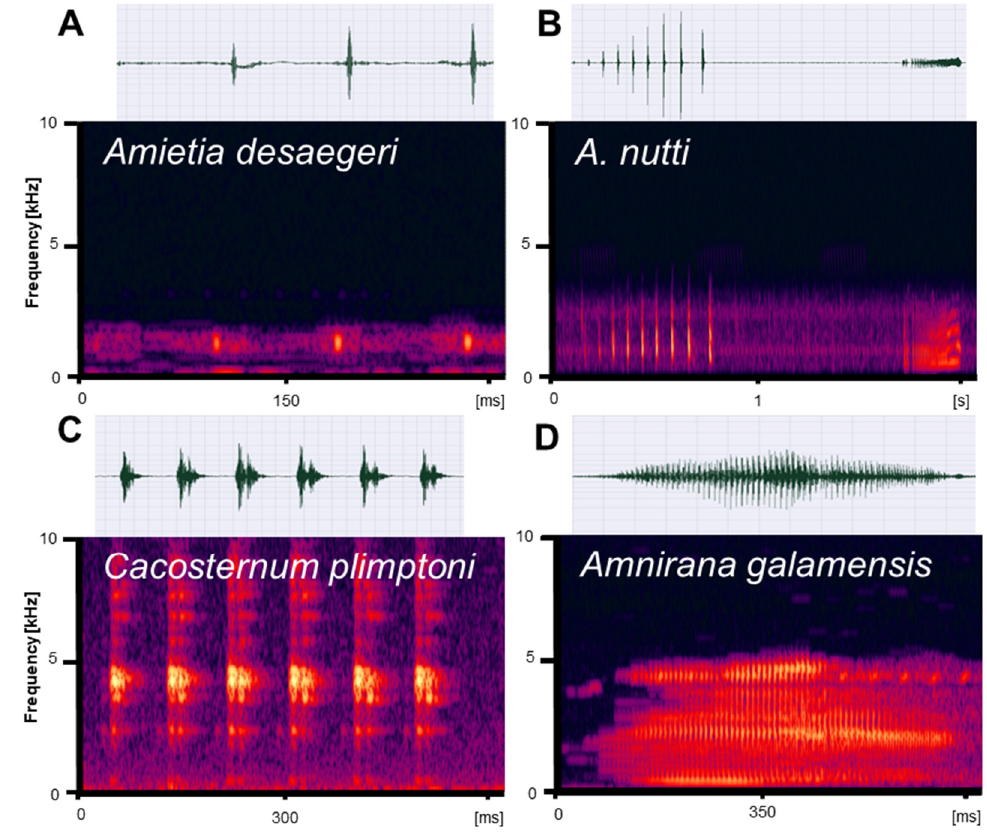
Figure 17. Advertisement calls of Rwandan Pyxicephalidae ( A ) Amietia desaegeri , ( B ) Amietia nutti , and ( C ) Cacosternum plimptoni ; and Ranidae ( D ) Amnirana galamensis (call recording from South Africa [107]). Calls are shown as representative spectrograms and oscillograms.